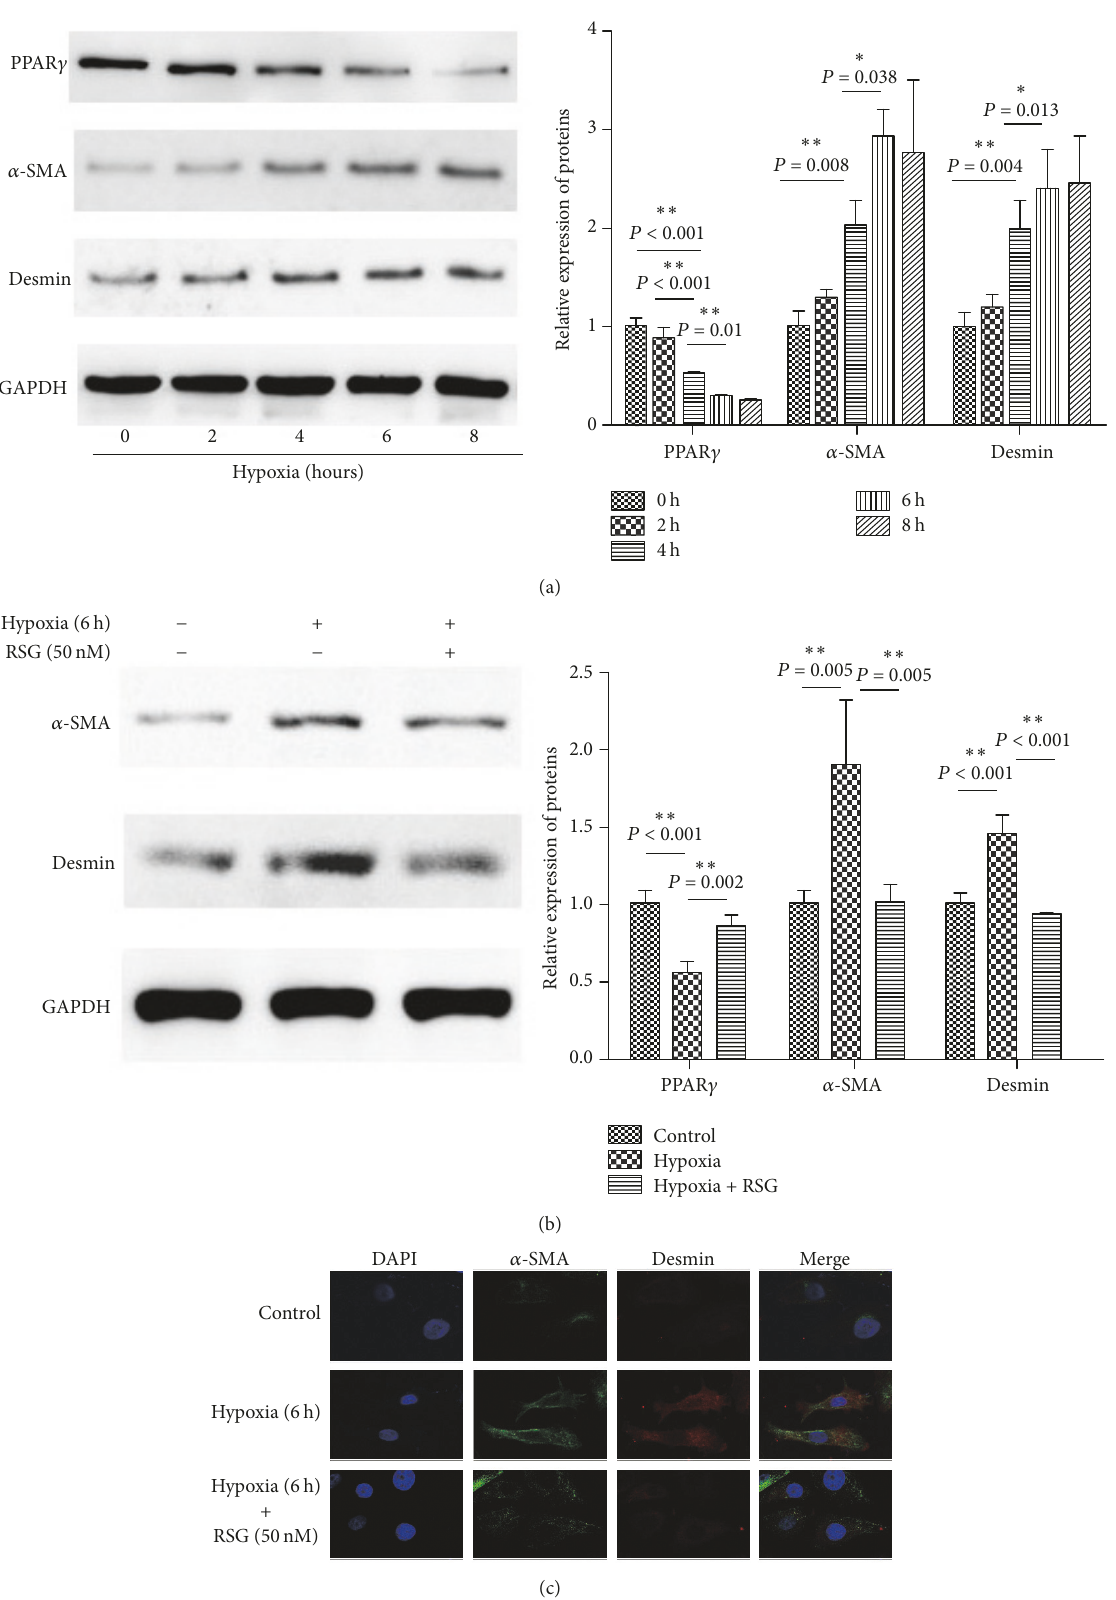
Figure 2: PPAR 𝛾 inhibits hypoxic-induced HSCs activation. (a) HSCs were exposed to hypoxia for the designated time. Protein expressions of PPAR 𝛾 , 𝛼 -SMA, and desmin were tested by western blotting. HSCs were exposed to hypoxia for 6 hours in the presence or absence of PPAR 𝛾 agonist, rosiglitazone (RSG, 50 nM). (b) PPAR 𝛾 , 𝛼 -SMA, and desmin expression of HSCs in experimental groups were analyzed by western blotting. (c) 𝛼 -SMA and desmin expression in HSCs in experimental groups were detected by immunofluorescence using Confocal microscopy. For each assay, 𝑛 = 3 . ∗ 𝑃 < 0.05 , ∗∗ 𝑃 < 0.01